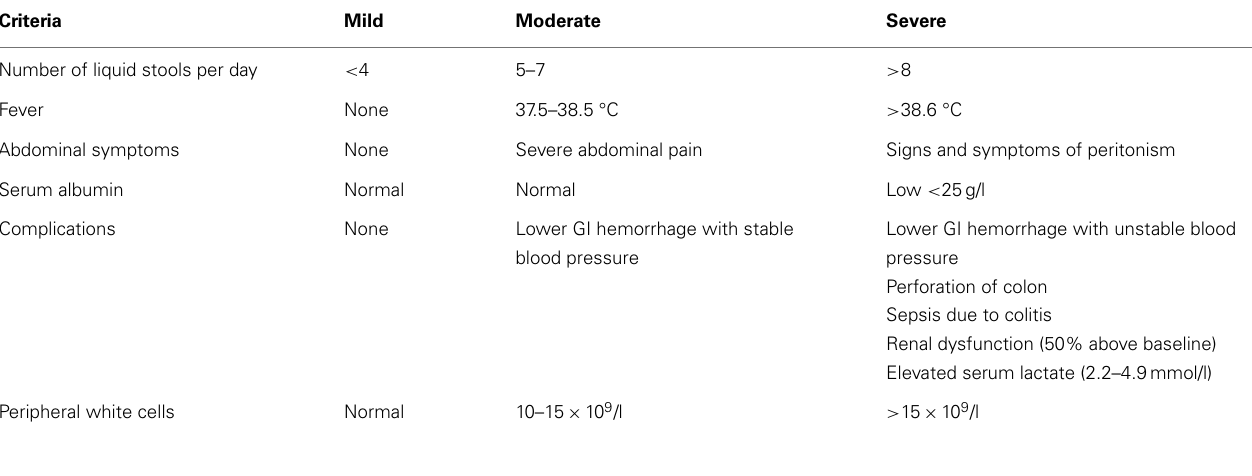
Table 1 | Grading of severity of C. difficile infection.